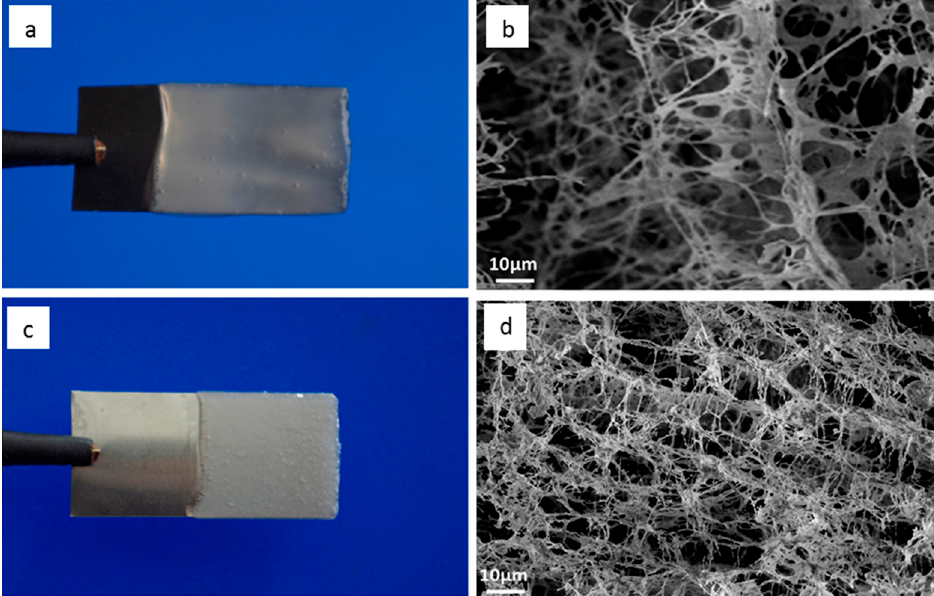
Figure 5. Optical picture ( a ) and SEM image ( b ) of electrodeposited chitosan without ibuprofen-mesoporous silica nanoparticles. Optical picture ( c ) and SEM image ( d ) of the chitosan coating embedding ibuprofen-mesoporous silica nanoparticles. (Reprinted with permission from [83] 2014 Elsevier, copyright n. 4557620011536).